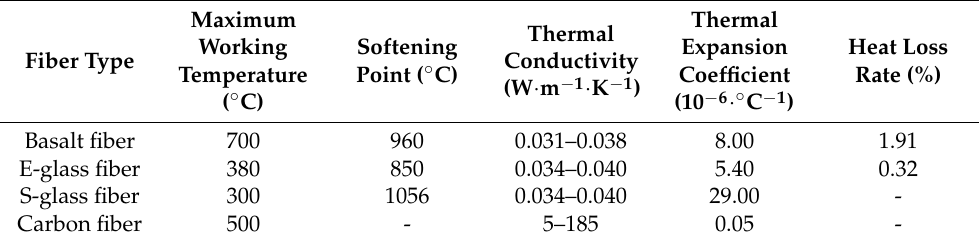
Table 2. Comparison of thermal properties between BF and other fibers